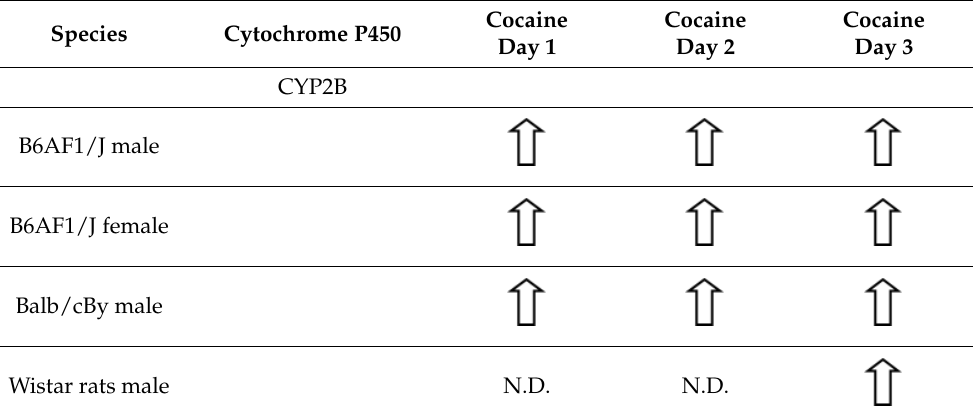
Table 1. Impact of the activation of brain dopaminergic pathways by different ligands of dopamin- ergic receptors on the activity and protein levels of cytochrome P450 (CYP) isoforms in rat liver microsomes. Table 3. Cont.